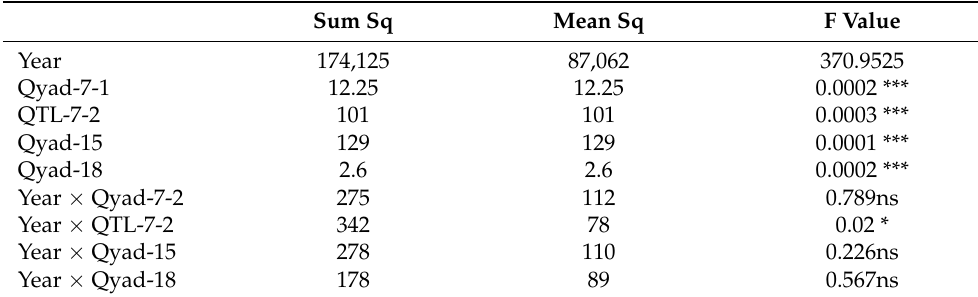
Table 5. QTL by environment analysis considering the major QTL.